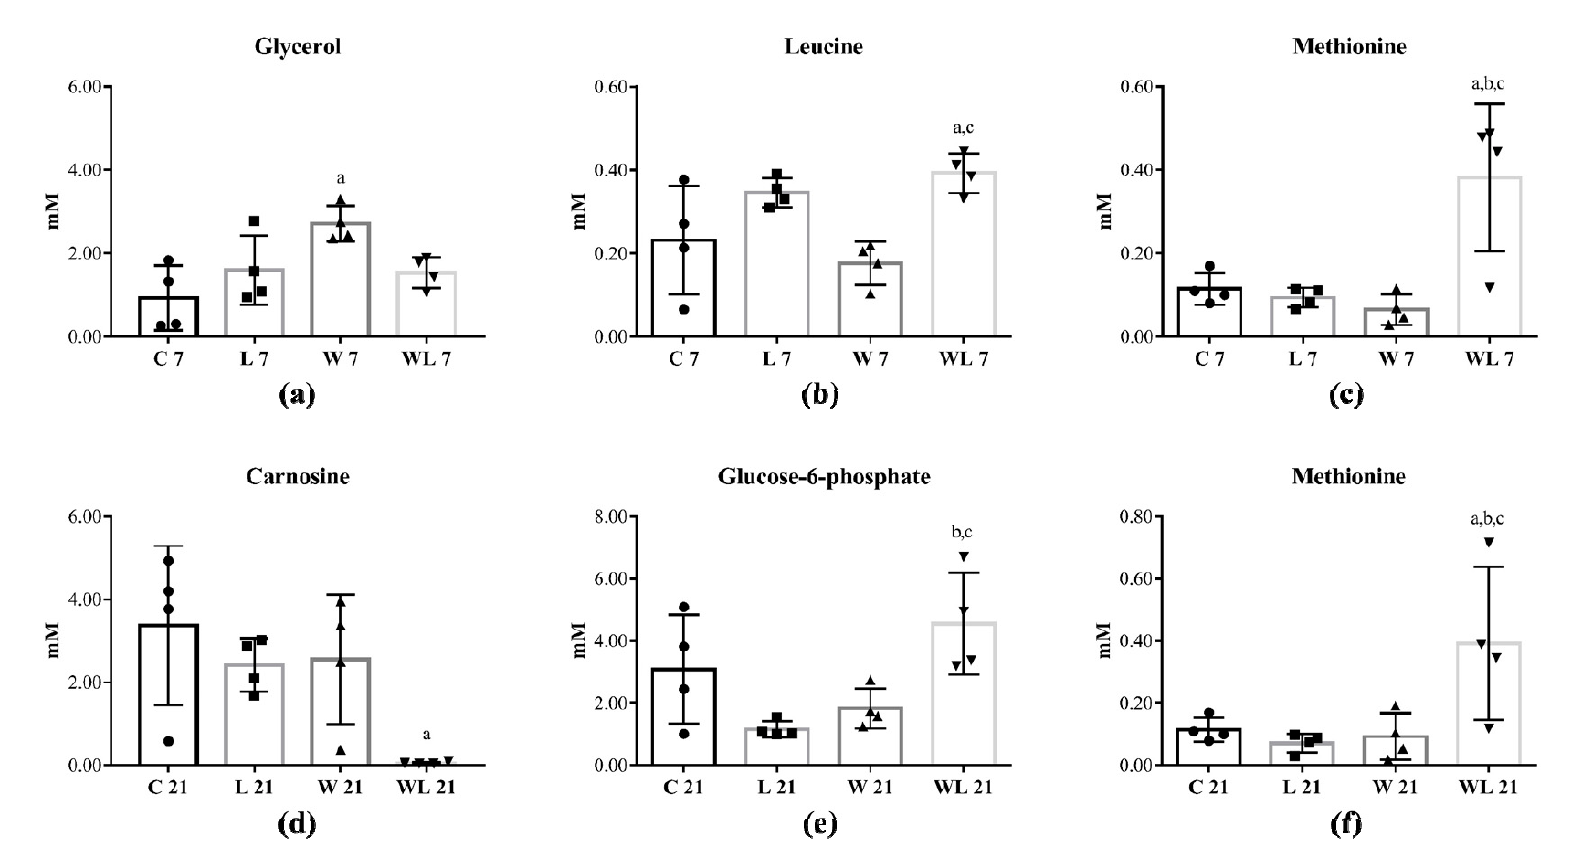
Figure 1. Skeletal muscle metabolic profile identified in rats euthanatised at 7th and 21st days of the experiment. Concentration of ( a ) Glycerol; ( b ) Leucine; ( c ) Methionine; ( d ) Carnosine; ( e ) Glucose-6-phosphate; ( f ) Methionine metabolites in different groups. Rats were distributed into control (C7 and C21); fed a leucine-rich diet (L7 and L21); Walker tumour-bearing (W7 and W21) and Walker tumour-bearing fed a leucine-rich diet (WL7 and WL21) euthanatised at 7th and 21st days of the experiment. Legend: C, control group; W, Walker tumour-bearing group; L, rats fed a leucine-rich diet; WL, tumour-bearing rats fed a leucine-rich diet. Data were expressed as mean ± standard deviation (SD) and analysed by one-way ANOVA followed by Tukey. ( a ) p < 0.05 comparison to C; ( b ) p < 0.05 comparison to L and ( c ) p < 0.05 comparison to W.